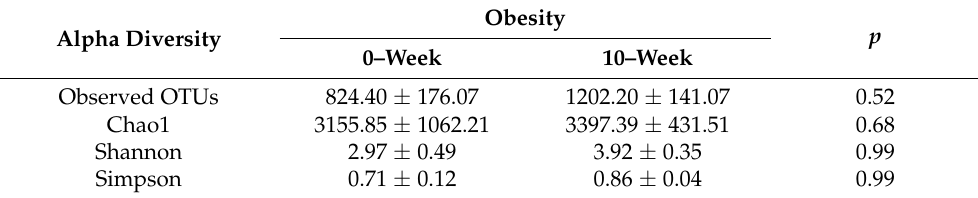
Table 4. Analysis of changes in intestinal microbial diversity in obese dogs according to synbiotic preparation containing L. gasseri BNR17